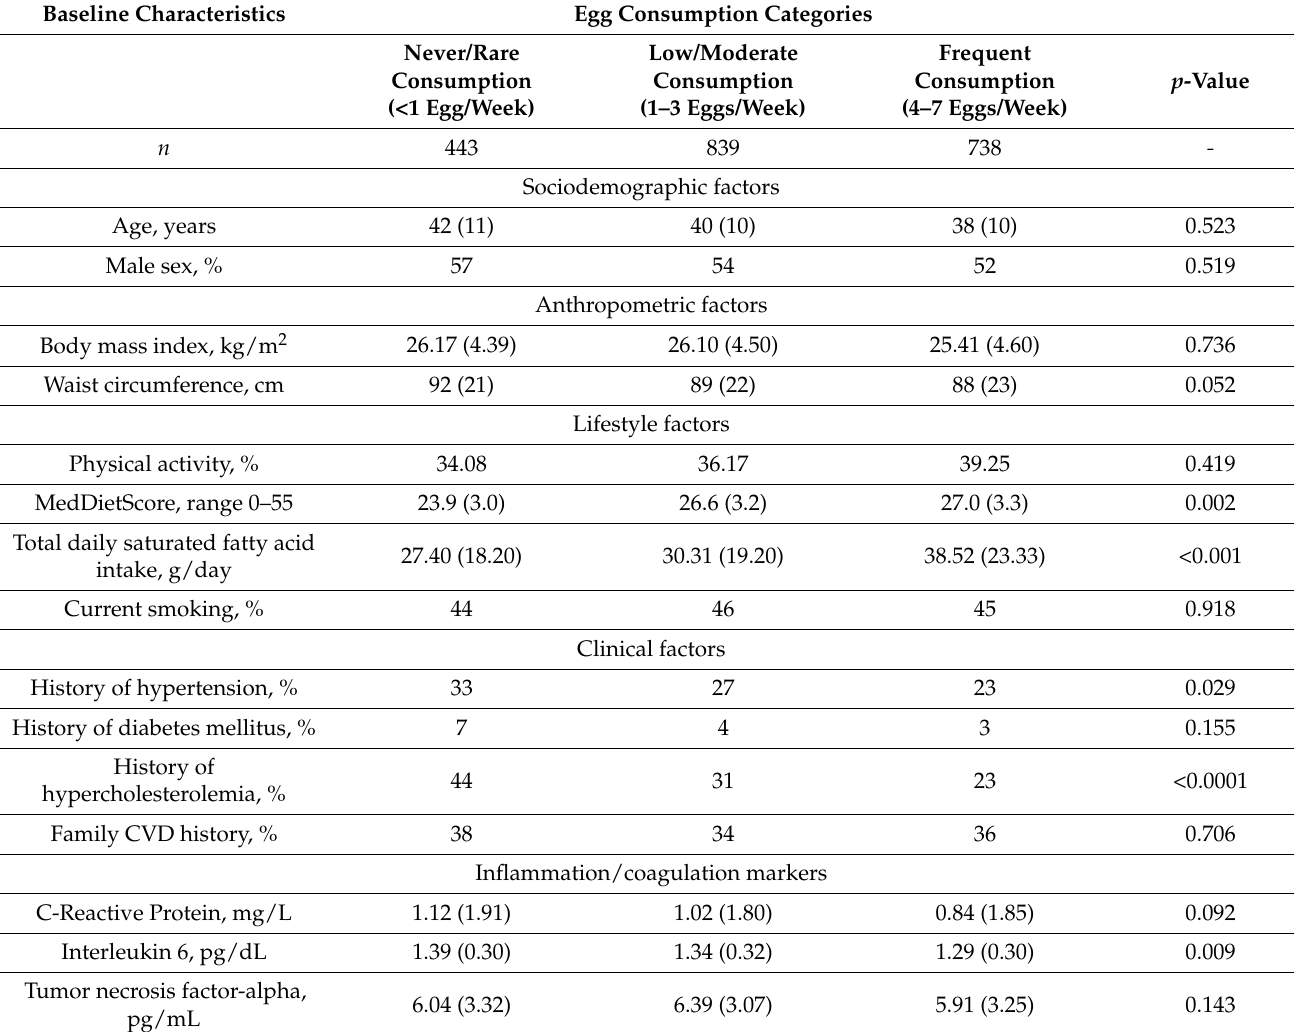
Table 1. Baseline sociodemographic, clinical, anthropometric, biochemical and lifestyle characteristics of subjects from the ATTICA study according to level of egg consumption ( n =